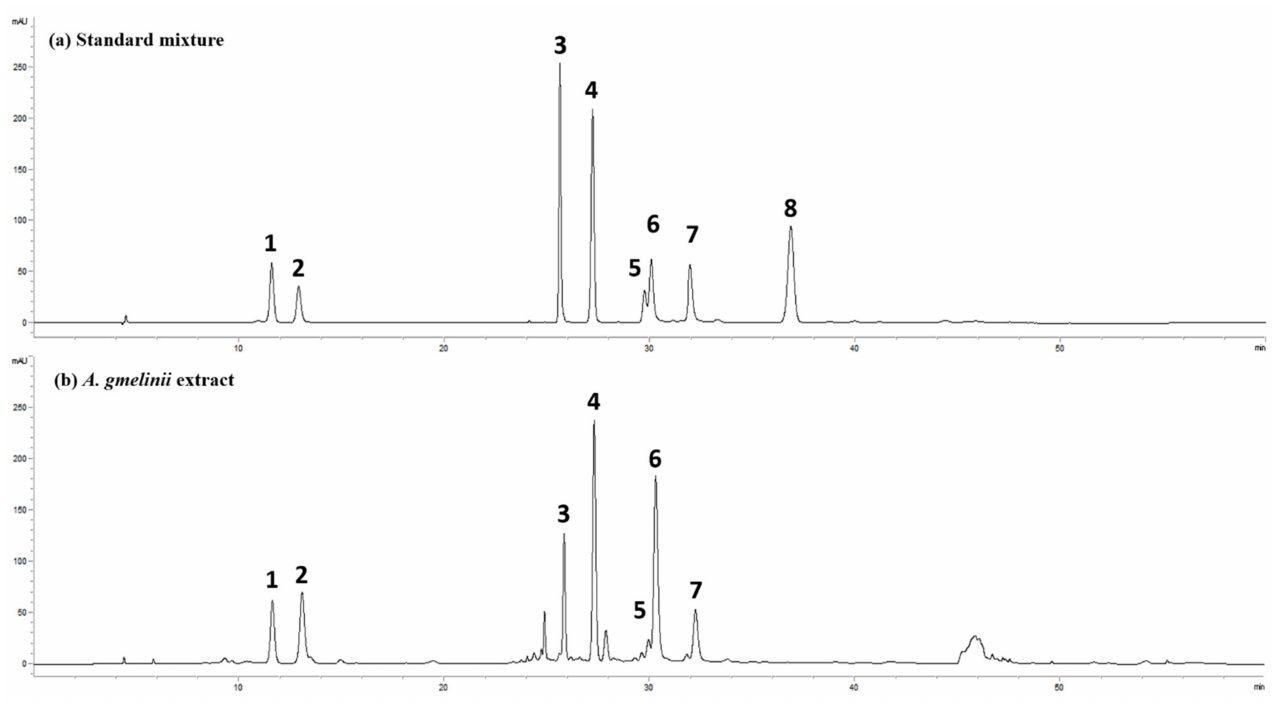
Figure 6. High-performance liquid chromatography profile of standard mixture ( a ) and